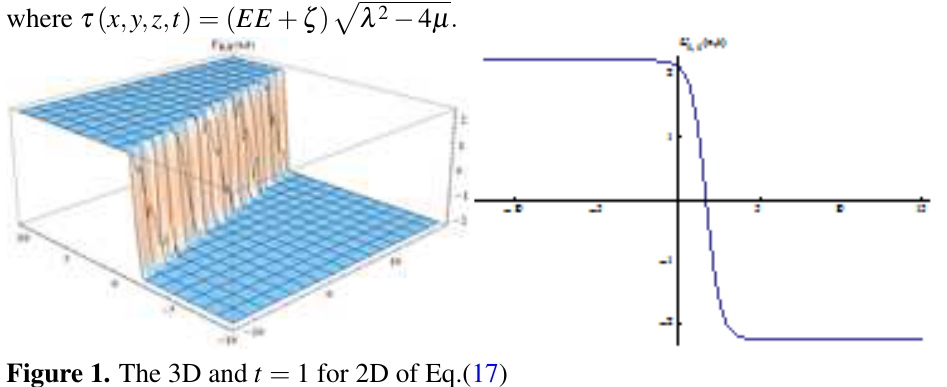
Figure 1. The 3D and t = 1 for 2D of Eq.(17)